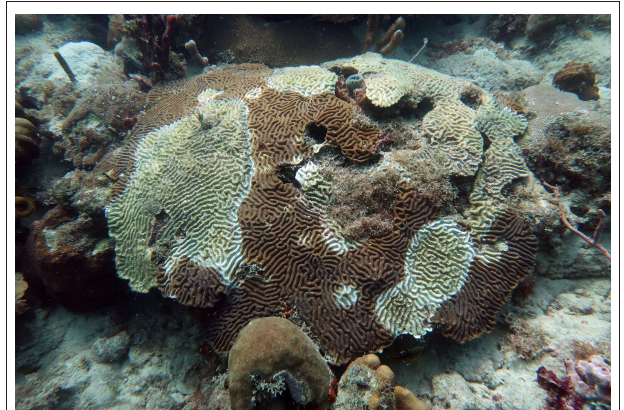
FIGURE 1 | Stony coral tissue loss disease (SCTLD) at the Black Point study site. A colony of C. natans affected by SCTLD, identified by the patches of exposed white skeleton indicating lesions that are quickly progressing (photo: Marilyn Brandt, August of